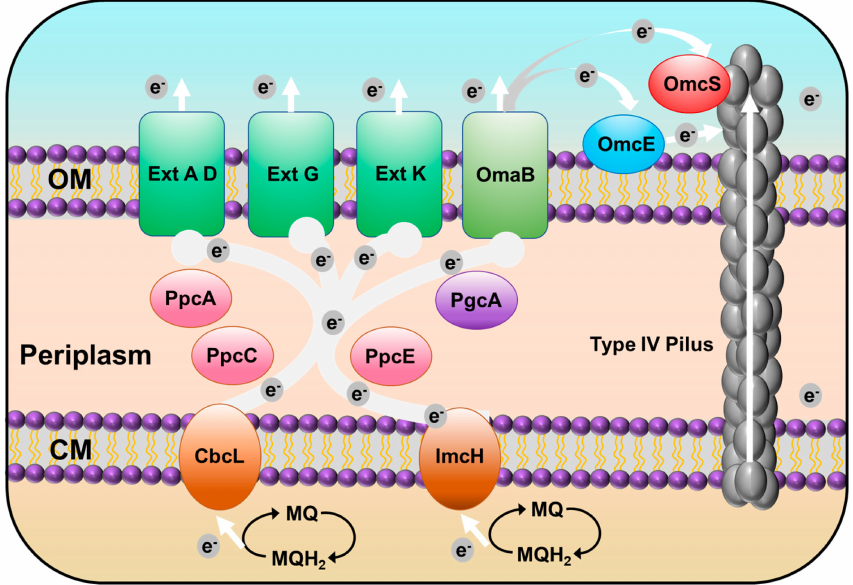
Figure 4. Proposed EET pathway of strain NIT-SL11. OM: outer membrane; CM: cytoplasmic